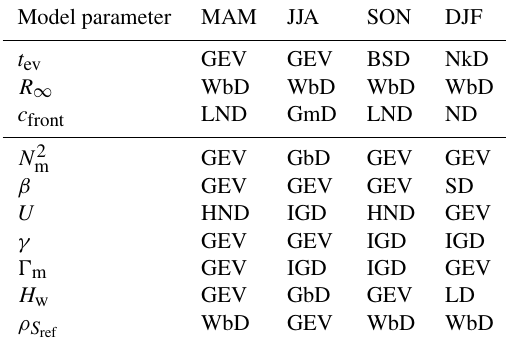
Table 2. Estimated best-fitting PDFs for event duration ( t ev ), back- ground precipitation R ∞ , and frontal enhancement factor c front de- rived from REGNIE data (top box); square of saturated Brunt– Väisälä frequency N 2 m , wind direction β , horizontal wind speed U , scaling height H w , actual lapse rate γ , saturated moist adiabatic lapse rate (cid:48) m , and condensation rate ρ S derived from sounding ref data (bottom box). For the PDF acronyms, see Table